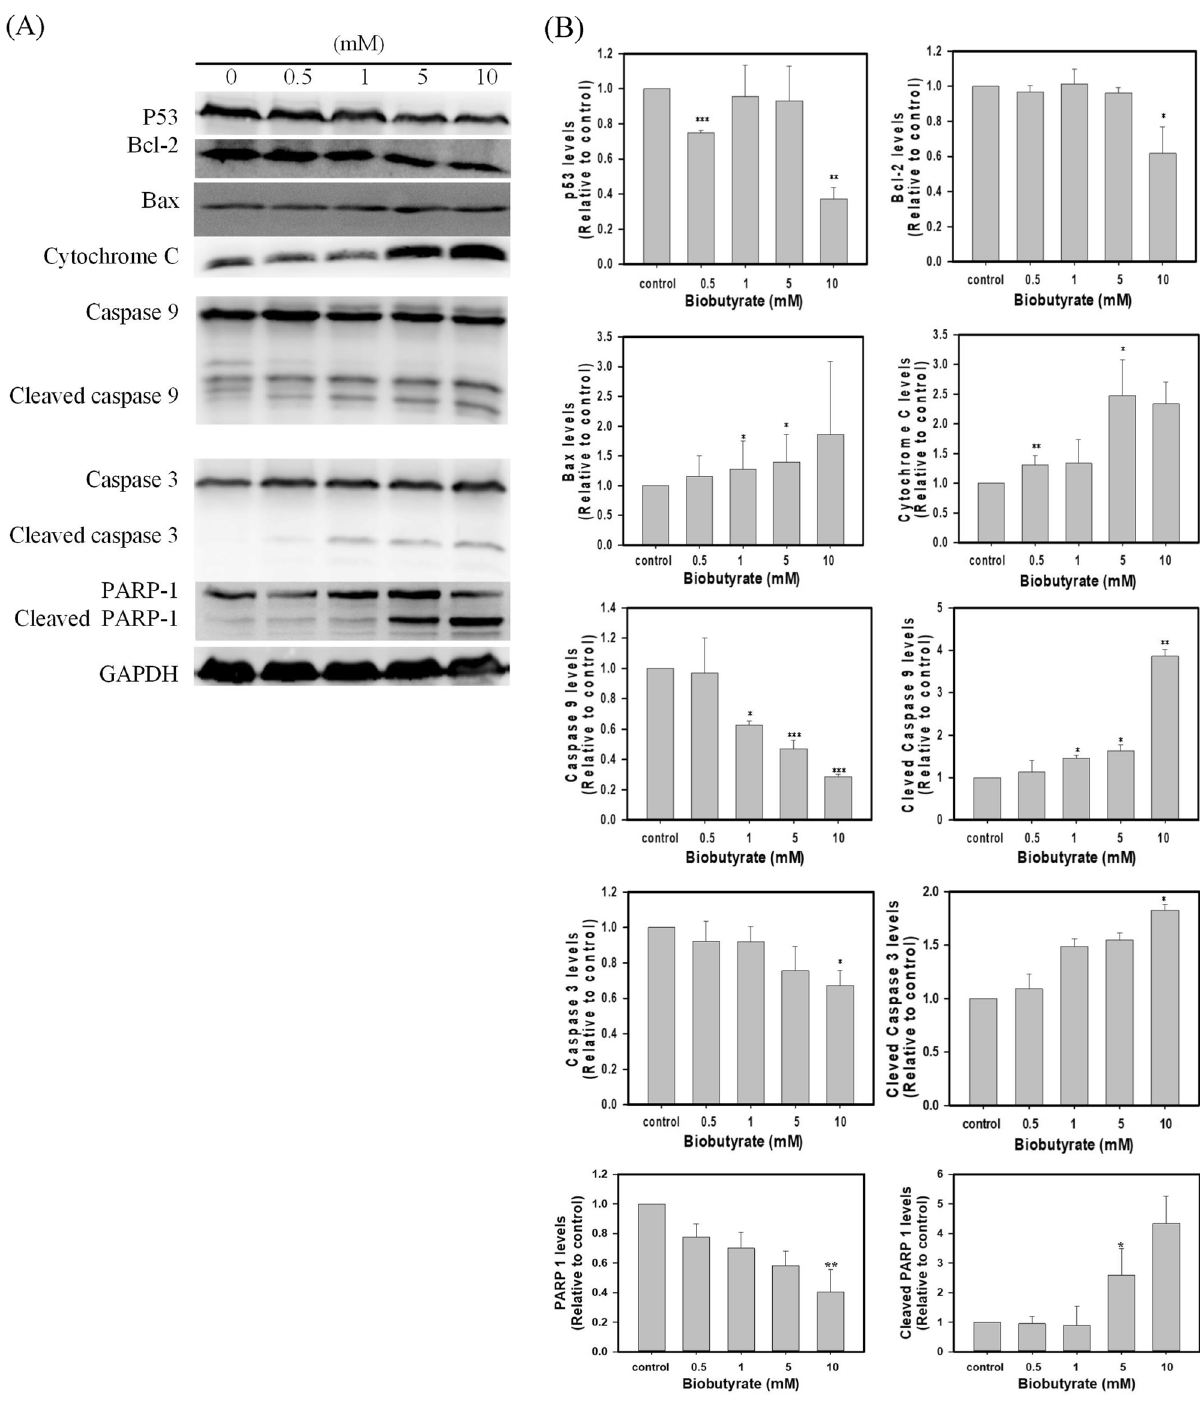
Figure 5. Effect of biobutyrate on the intrinsic apoptosis pathway. ( A ) The immunoblotting analysis of proteins associated with caspase-dependent apoptosis. Cancer cells were treated with various doses of biobutyrate for 48 h, and protein levels were determined by the immunoblotting analysis. The level of GADPH was used as the internal control. ( B ) Quantification of protein levels. Full-length blots are presented in Supplementary Fig. 5C. Data were taken from three independent experiments by the ImageJ Image Analysis software and analyzed using the GraphPad Prism 7 software (* p < 0.05, ** p < 0.01 and *** p < 0.001 vs. vehicle control based on one-way ANOVA) and graphs were prepared using SigmaPlot 10.0 (Systat Software, San Jose,